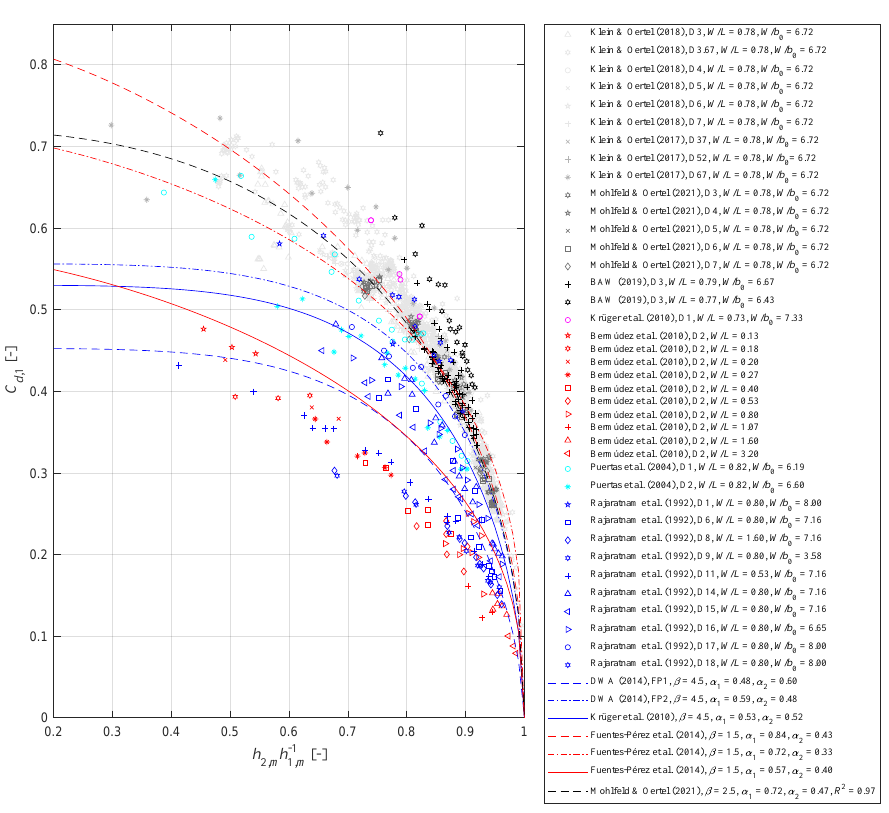
Figure 3. Discharge coefficients and existing fitting equations according to Equation (3) based on Poleni (Equation (2))